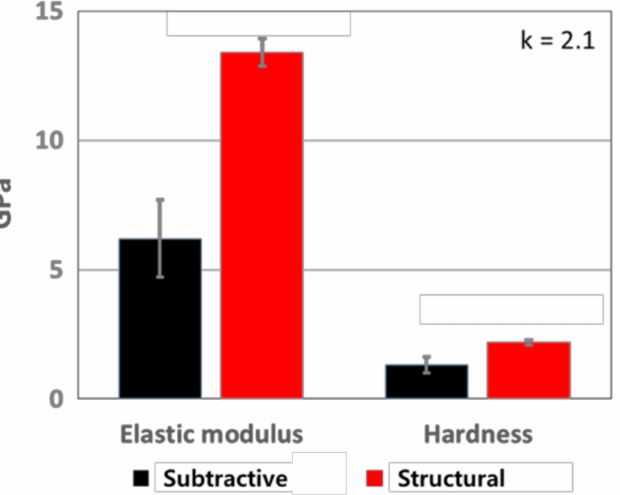
Figure 1. Comparison of elastic modulus and hardness between subtractive and structural p- SiCOH